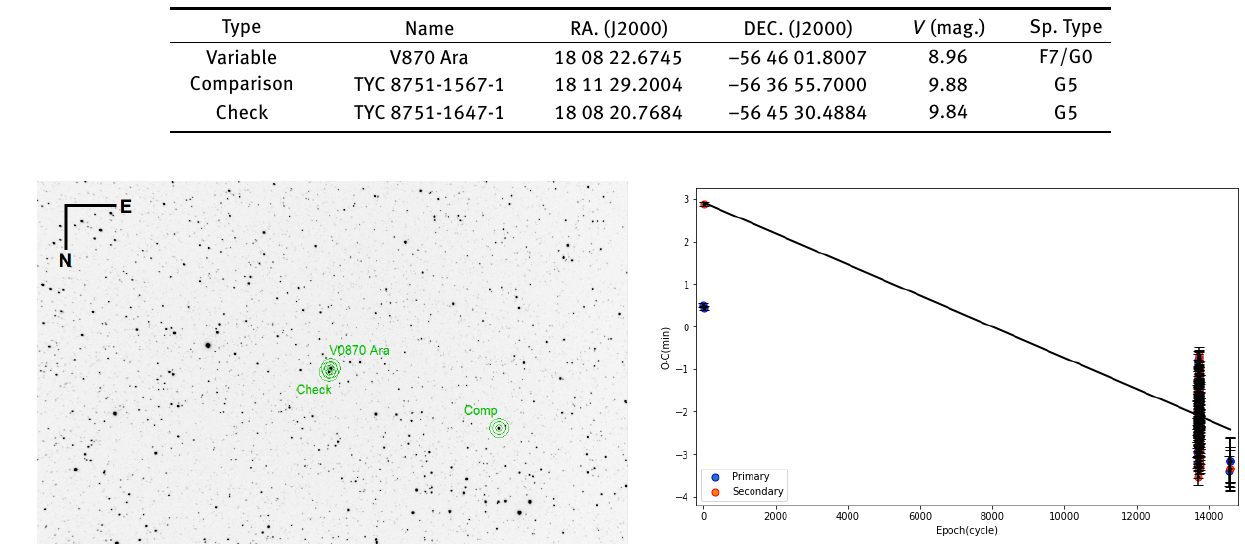
Table 1. Characteristics of the binary system, comparison star, and check star (from Simbad http://simbad.u-strasbg.fr/simbad/).